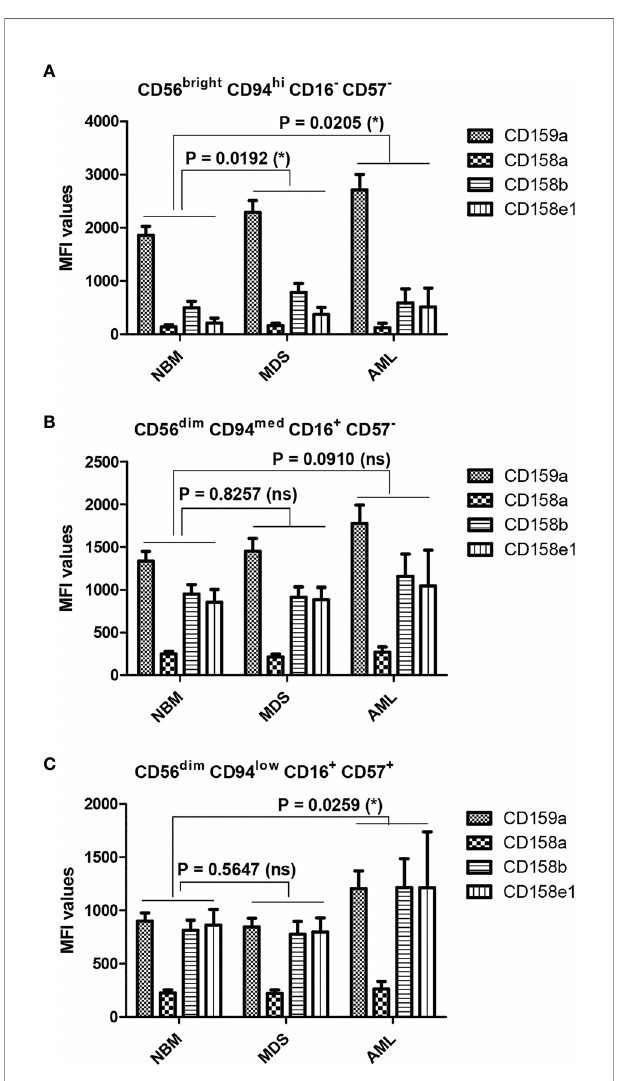
FIGURE 8 | Differences in the repartition of CD159a and KIR receptors in distinct NK maturation subsets within the bone marrow microenvironment of NBM, MDS, and AML cases. (A) Mean fl uorescence intensity (MFI) of CD159a and KIR receptors on the surface of bone marrow CD56 bright CD94 hi CD16 - CD57 - immature NK cells in normal bone marrow (NBM, n = 30), myelodysplastic syndromes (MDS, n = 25), and acute myeloid leukemia (AML, n = 8) cases. Bars represent the mean ± SEM (*P < 0.05; two-way ANOVA followed by Bonferroni post-test). (B) Mean fl uorescence intensity (MFI) of CD159a and KIR receptors on the surface of marrow CD56 dim CD94 med CD16 + CD57 - mature NK cells in NBM (n = 30), MDS (n = 25), and AML (n = 8) cases. Bars represent the mean ± SEM (ns, not signi fi cant; two-way ANOVA followed by Bonferroni post-test). (C) Mean fl uorescence intensity (MFI) of CD159a and KIR receptors on the surface of bone marrow CD56 dim CD94 low CD16 + CD57 + hypermature NK cells in NBM (n = 30), MDS (n = 25), and AML (n = 8) cases. Bars represent the mean ± SEM (*P < 0.05; two-way ANOVA followed by Bonferroni